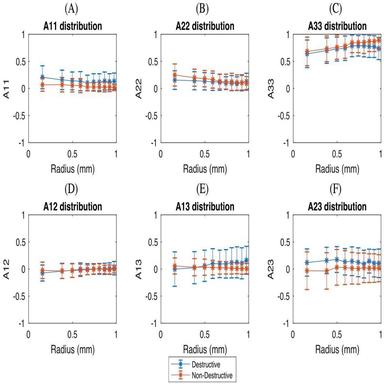
The radial fiber orientation distribution averaged along equal area concentric annuli of the specimen for (A) A11, (B) A22, (C) A33, (D) A12, (E) A13, and (F) A23 from both non-destructive and destructive characterization of the same fibers.